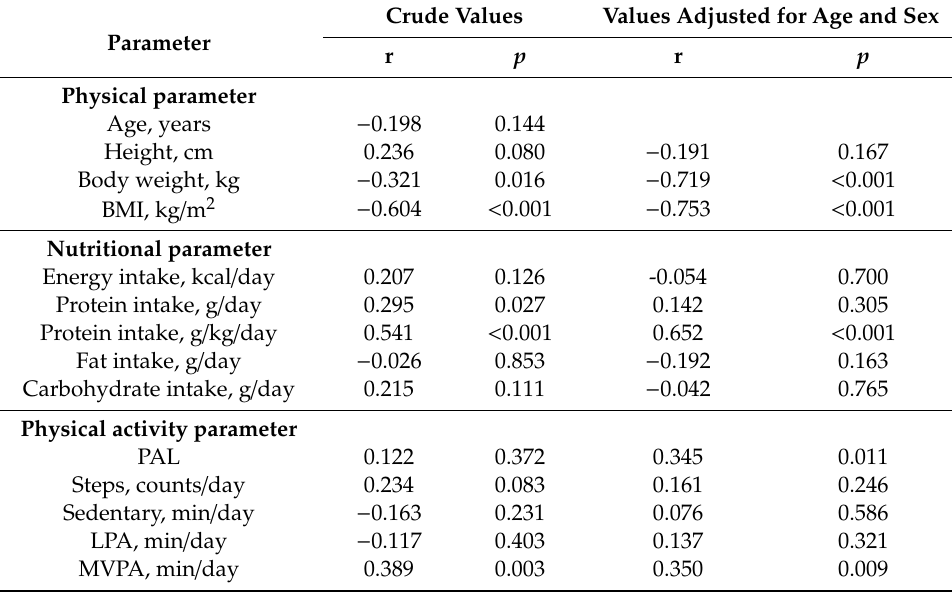
Table 2. Associations between the percentage of FFM and other parameters.